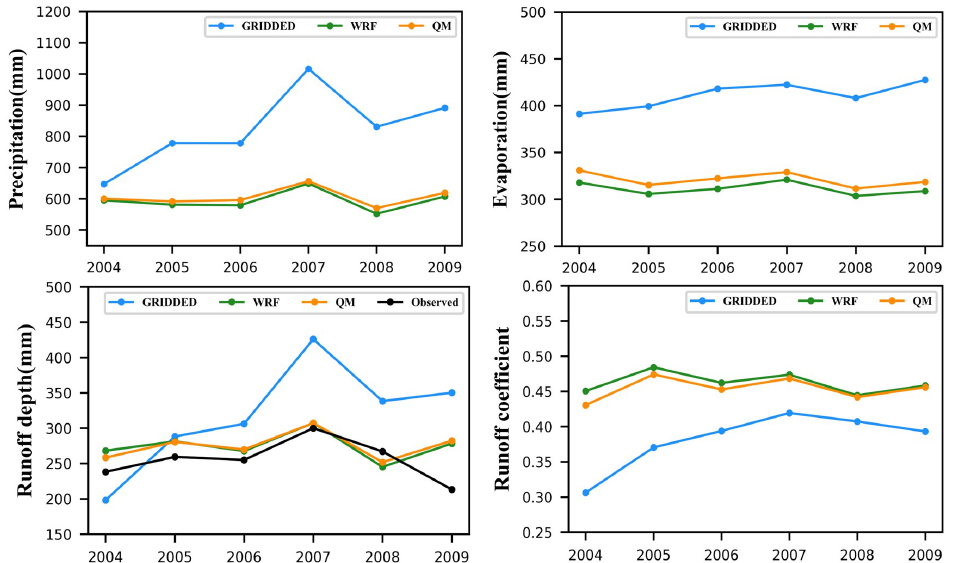
Figure 7. A comparison of annual precipitation, evaporation, runoff depth, and the corresponding runoff coefficient from the simulated results of the GRIDDED precipitation, the WRF downscaled precipitation, and the QM frequency corrected precipitation data. The observed runoff depth means the reference annual runoff depth obtained by averaged annual discharges to the whole Manas